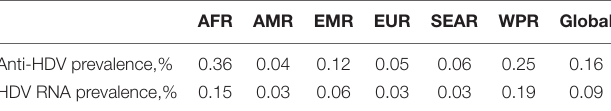
TABLE 1 | Estimates of HDV prevalence in the general population (95% CI) [Source: Stockdale et al.